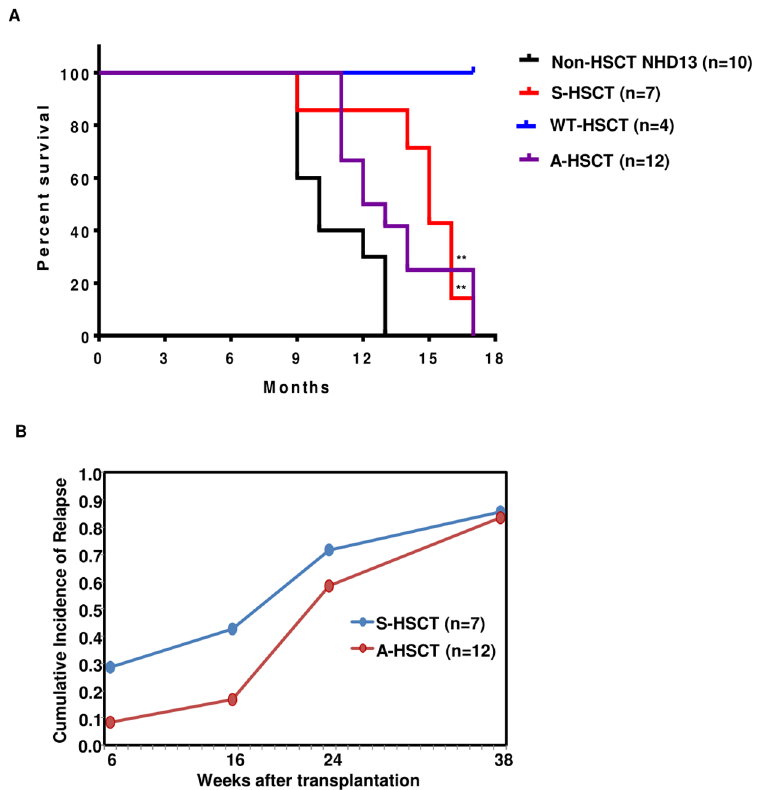
Fig 3. Overall survival and cumulative incidence of relapse. (A) Log RANK test for Non-HSCT vs S-HSCT, p = 0.0013; Non-HSCT vs A- HSCT, p = 0.0054; Allo HSCT vs Syn HSCT, p = 0.7373. Non-HSCT NHD13refers to NHD13transgenic mice not subjectedto myeloablative irradiationand HSCT. WT-HSCT refers to WT recipientmice transplanted with WT syngeneicBMNC followingmyeloablative irradiation. (B) Cumulative incidenceof relapse for S-HSCT and